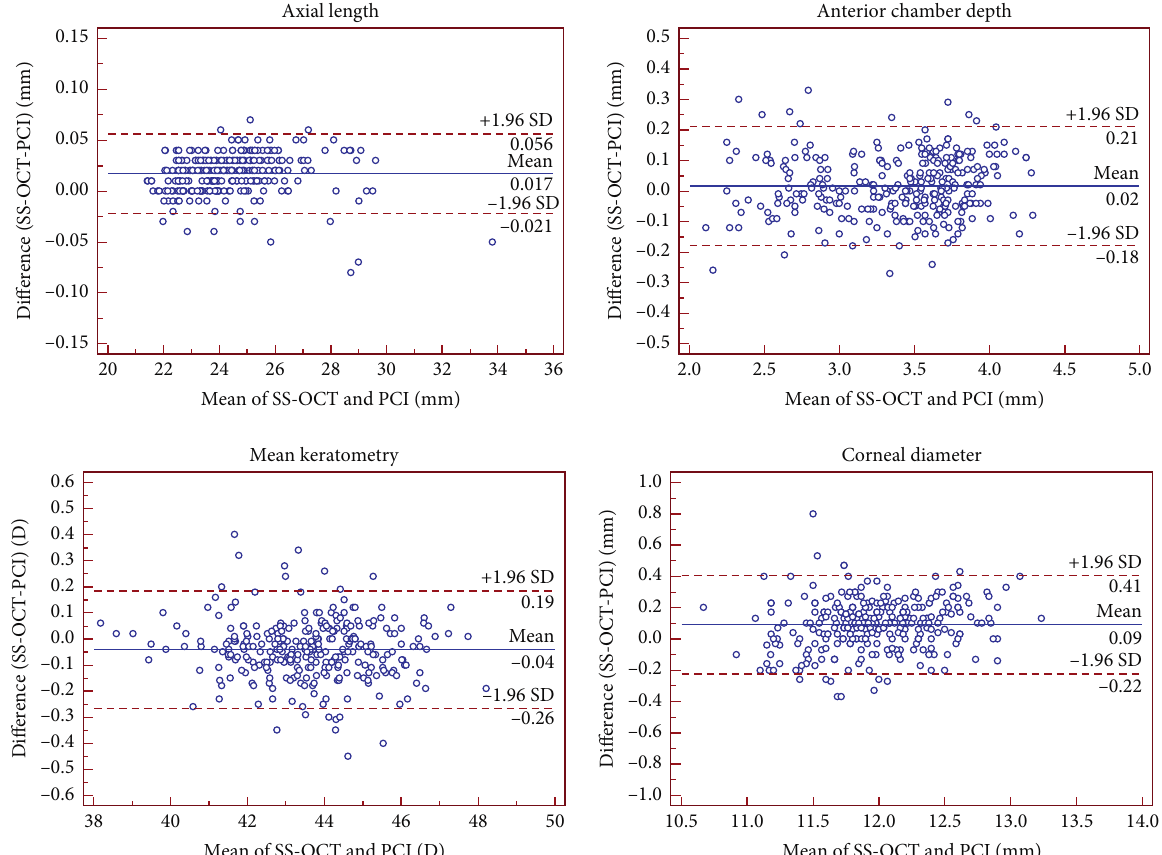
Figure 1: Bland–Altman plot of the axial length, anterior chamber depth, mean keratometry and corneal diameter measurements using the IOLMaster 700 swept-source optical coherence tomography against IOLMaster partial coherence interferometry. The solid line represents the mean difference. The dotted lines on the side represent the upper and lower 95%